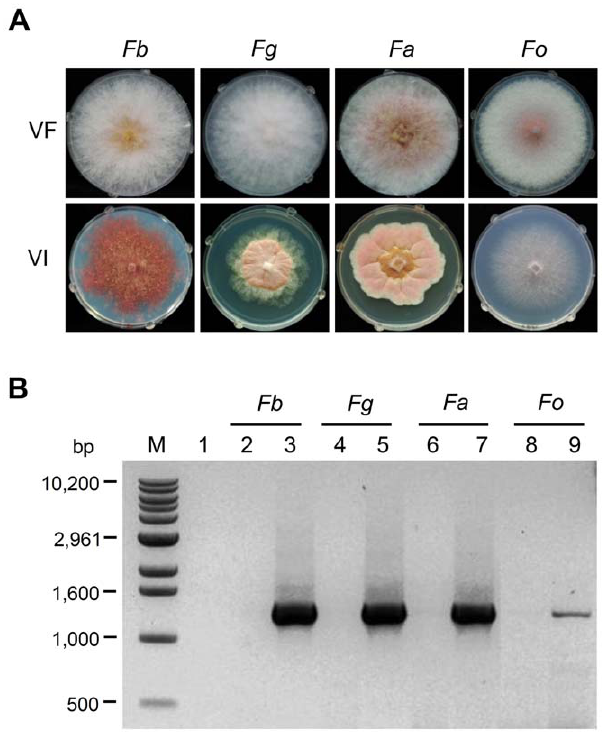
Figure 3. Phenotype of fungal colonies and reverse-transcription polymerase chain reaction (RT-PCR) analysis of Fusarium strains. Fb = F. boothii ; Fg = F. graminearum ; Fa = F. asiaticum ; Fo = F. oxysporum f. sp. lycopersici . (A) Colony morphology of virus-free (VF) and virus- infected (VI) strains by protoplast fusion. (B) RT-PCR analysis of dsRNA in fungal strains. Lane M, 1-kb ladder DNA size marker; lane 1, negative control (no DNA template); lanes 2, 4, 6, and 8, virus-free strains; lanes 3, 5, 7, and 9, virus-infected strains. Presence of viral dsRNA was confirmed by RT-PCR amplification with a primer pair designed from the RdRp sequence of